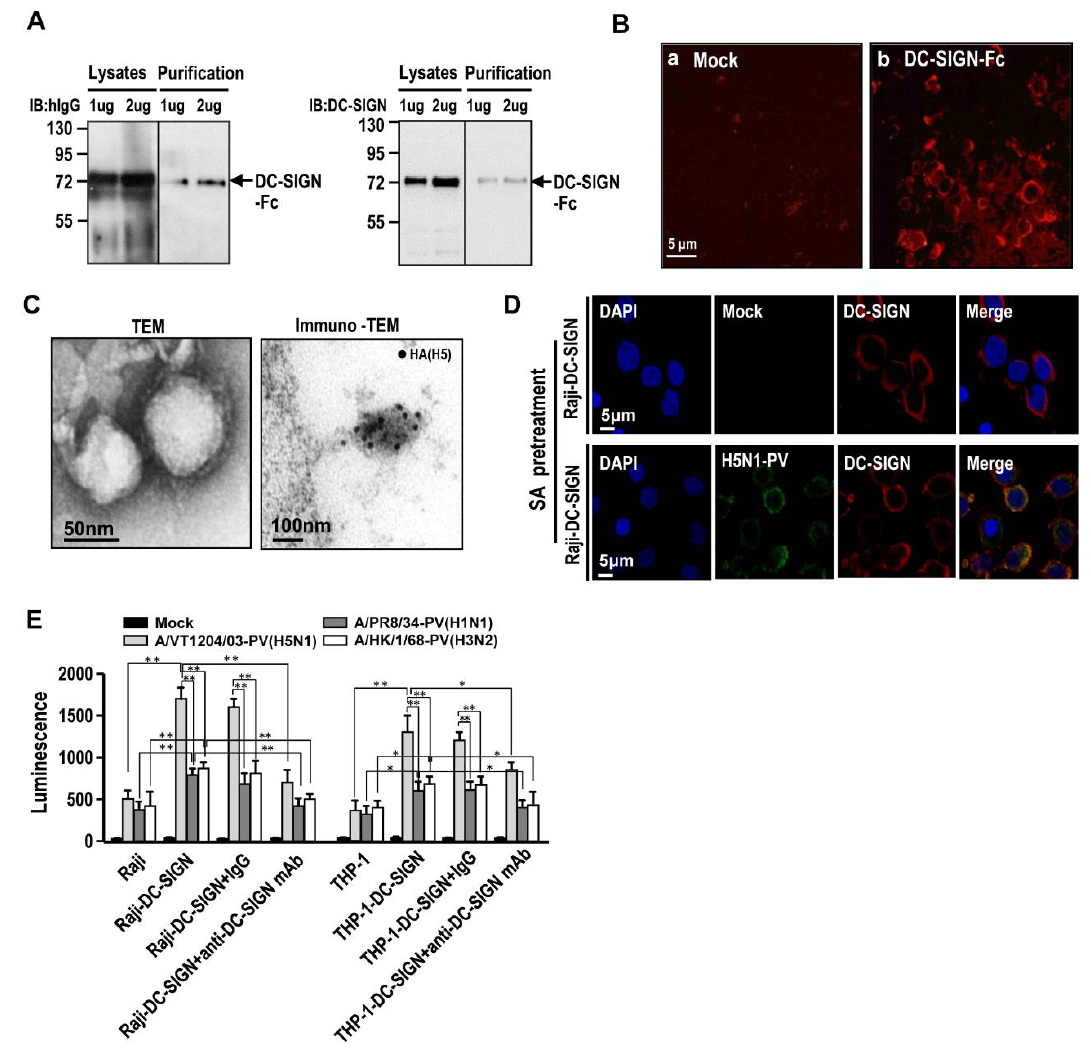
Figure 3. Generation of recombinant DC-SIGN and H5N1 pseduotyped virus. ( A ) The plasmid encoded extracellular carbohydrate interacting domain (ECD) of DC-SIGN with Fc tag was transfected into Freestyle HEK 293F cells and incubated in an orbital shaker incubator for a further 48 h at 37 ◦ C, 120 rpm, and 5% CO2. The supernatants were collected and subjected to further purification by protein A beads. The total lysates and purified recombinant DS-SIGN-ECD-Fc proteins were subjected to immunoblotting using anti-human IgG (the left) or anti-DC-SIGN antibodies (the right) to check protein expression level. ( B ) Mock and pDC-SIGN ECD-Fc transfected cells were subjected to immunofluorescent staining with mouse anti-DC-SIGN antibodies followed by the addition of red fluorescent labeled antibodies against the primary antibodies. The stained cells were observed using a fluorescent microscope. ( C ) Avian H5N1 pseudotyped viruses (PVs) were generated by using co-transfection of pNL-Luc-E-R- vector with pHW1203-HA and pHW1203-NA vectors into HEK293T cells. Cell supernatant containing H5N1-PVs were collected 48 h post-transfection. After purification and concentration by ultracentrifugation, the virions were subjected to transmission electron microscope (TEM), as well as immuno-transmission electron microscope (immuno-TEM) which was stained with anti-HA (H5) antibodies, followed by the addition of gold labeled antibodies against the primary antibodies. ( D ) Sialidase pretreated Raji-DC-SIGN cell were incubated with mock or H5N1-PVs treatment at 4 ◦ C for 2 h for viral binding and subjected to immunofluorescent staining with anti-HA (H5) and anti-DC-SIGN antibodies, followed by the addition of green (for HA) and red (for DC-SIGN) fluorescent labeled antibodies against the primary antibodies and then subjected to Carl Zeiss LSM 700 Confocal Microscope observation. ( E ) Comparison the infectivity among lentivirus pseudotyped with H5N1, H1N1, and H3N2 envelope in Raji and Raji-DC-SIGN cells. Representative results are shown. Quantitative data represent the means ± SD of results from at least three independent experiments (* p < 0.05; ** p <